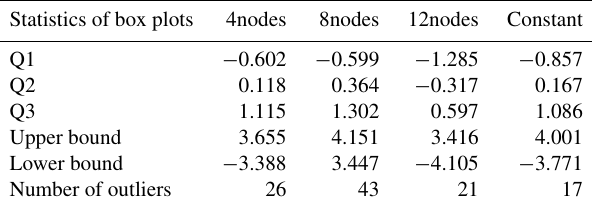
Table 3. Characteristic values of box plots of the four schemes and water vapor measurements constructed by HKKP’s radiosonde data for 7 days (DOY 221–227) in